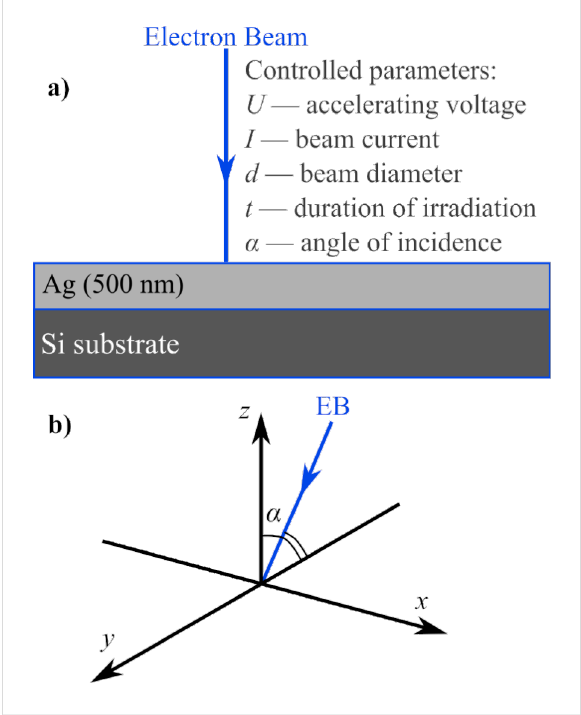
Figure 1: a) Structure of samples and experimental setup of their irra- diation. b) Coordinate system for the angle of incidence of the